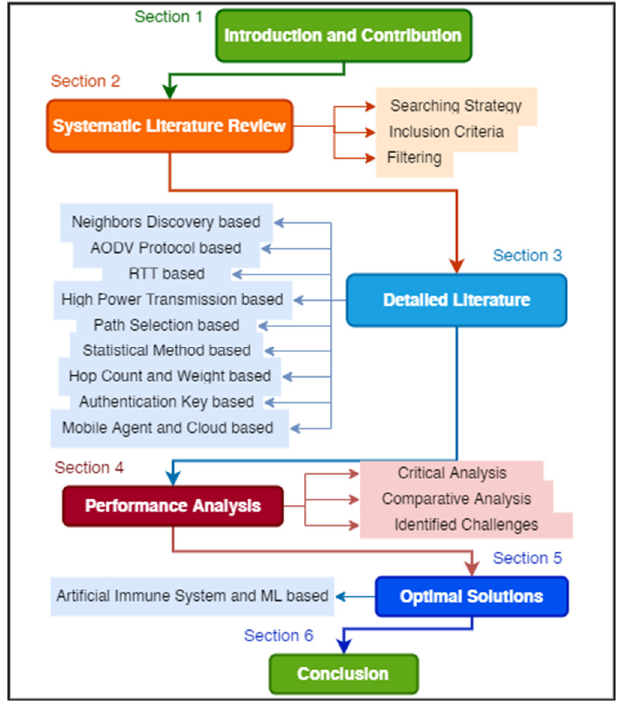
Figure 3. Paper organization.